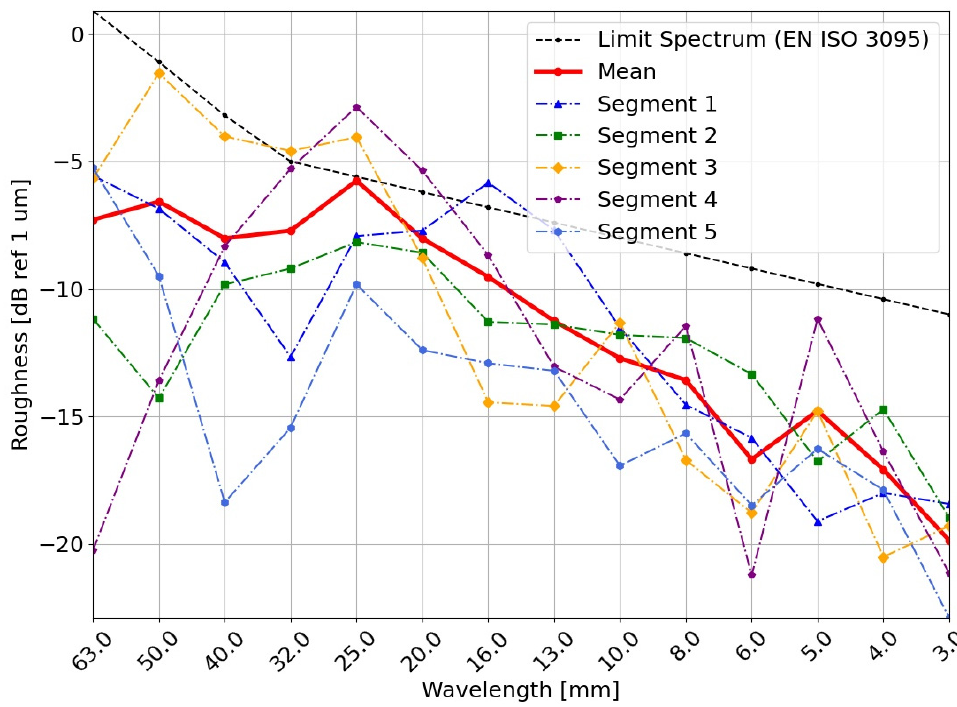
Figure 5. The spectrum of acoustic roughness for stylus 2 and reference section B (Mean), the five segments measured by SBB and the limit spectrum from EN ISO 3095 [22].